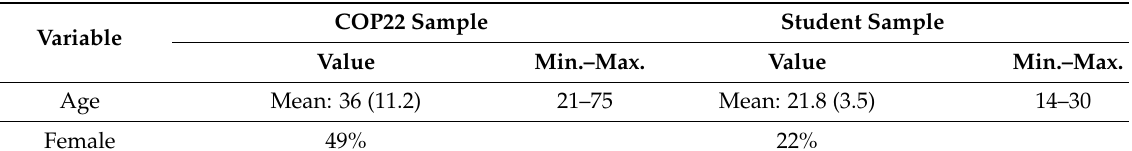
Table 1. United Nations Climate Change Conference in Marrakesh, 2016 (COP22) and student sample